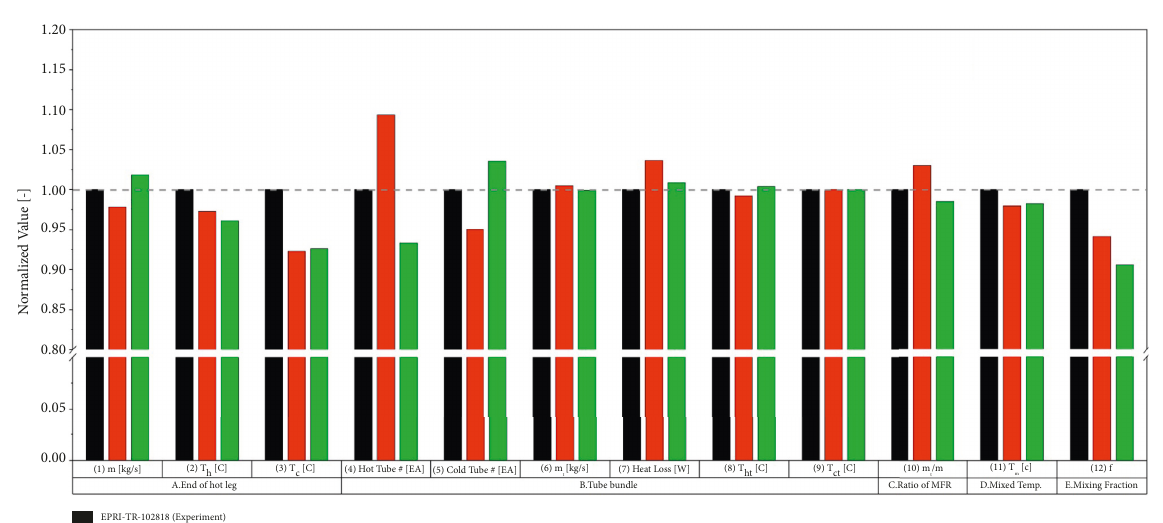
Figure 8: Comparison of the main evaluation factors between previous studies and CFD analysis (normalized